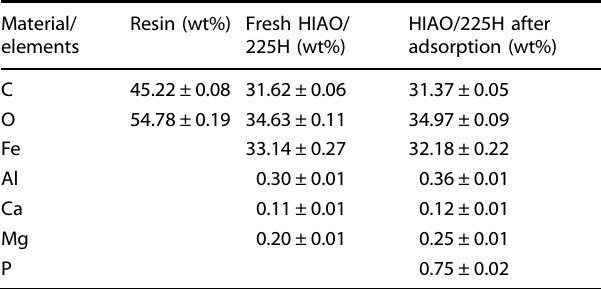
Table 1. Elemental composition (wt%) of material as determined by EDX.